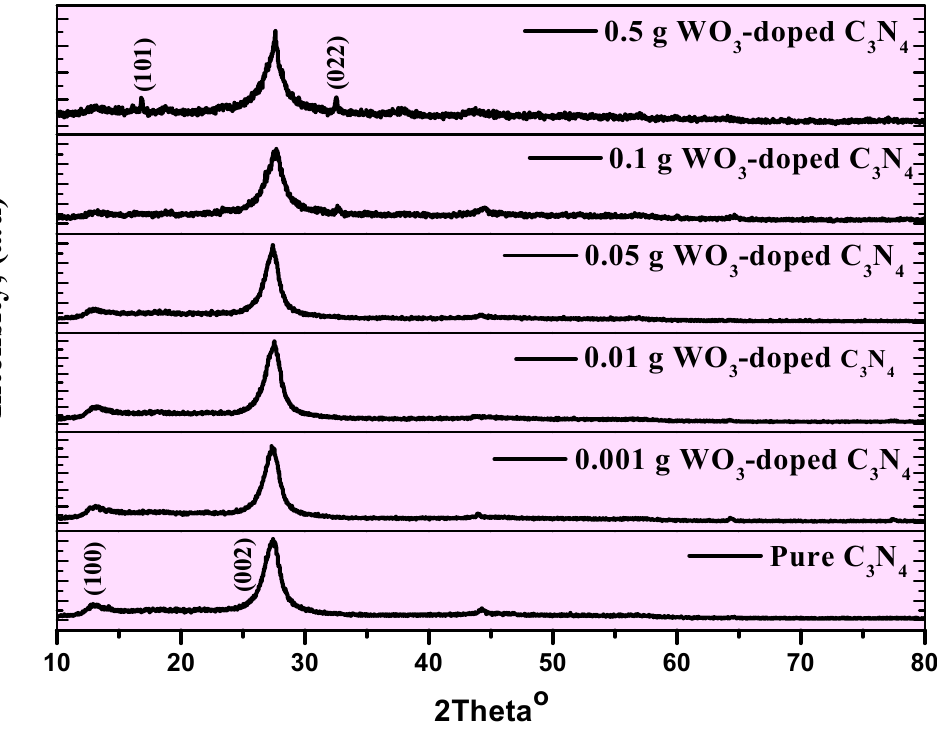
Figure 1. XRD patterns of pure g-C 3 N 4 powder and its WO 3 doping on g-C 3 N 4 composite organic compounds (0.001, 0.01, 0.05, 0.1, and 0.5 g of WO 3 ).